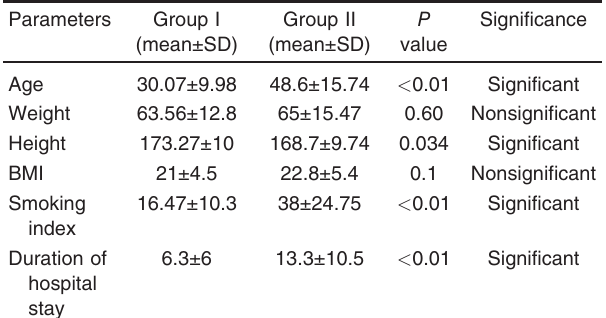
Table 2 Descriptive and analytical data of the demographics and the duration of hospital stay of the studied patients Parameters